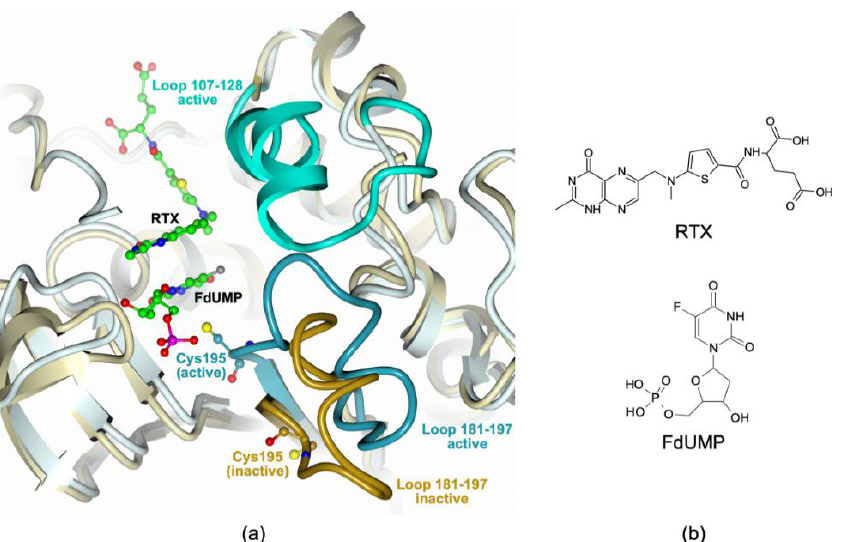
Figure 1. ( a ) Least-squares superposition of hTS in the active (light cyan ribbons; hTS:FdUMP:RTX complex, PDB id: 6ZXO) and inactive (light gold ribbons, PDB id: 3N5G [33]) conformations. The structured loop (residues 181–197) is shown as either a dark cyan or a dark gold rope for the active and inactive conformer, respectively. The different orientations of the catalytic Cys195 residues, represented as balls and sticks, can be appreciated. When the 181–197 loop is in the active conformation, loop 107–128 is structured (cyan rope) whereas it is disordered, thus not visible, when loop 181–197 is in the inactive conformation. The FdUMP and RTX molecules, bound to the “closed” active site, are represented as balls and sticks (green carbons). Oxygen atoms are colored red, nitrogen blue, sulfur yellow, phosphorous magenta, and fluorine gray. ( b ) Chemical structures of RTX and